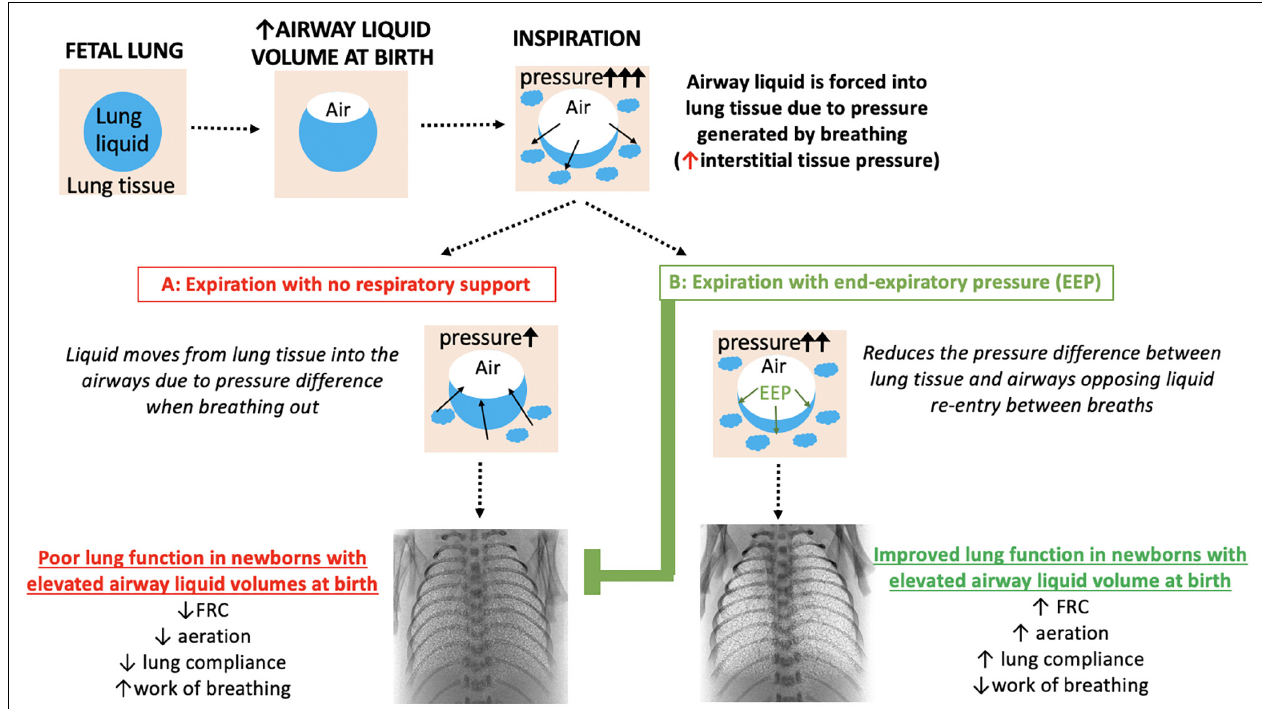
FIGURE 3 | Schematic overview of how respiratory support with an end-expiratory pressure (EEP) supports lung function in near-term newborns with elevated airway liquid volumes at birth. Blue, lung liquid; beige, lung tissue. Included are synchrotron phase contrast X-ray images of newborn rabbits (equivalent to 38 weeks gestational age in terms of humans lung development) with elevated airway liquid volume at birth receiving respiratory support with no end-expiratory pressure ( A: 0 cmH 2 O) or a positive end-expiratory pressure of 8 cmH 2 O (B) via mechanical ventilation to show the effect on lung aeration [white speckle pattern; reproduced with permission (12)]. FRC, functional residual